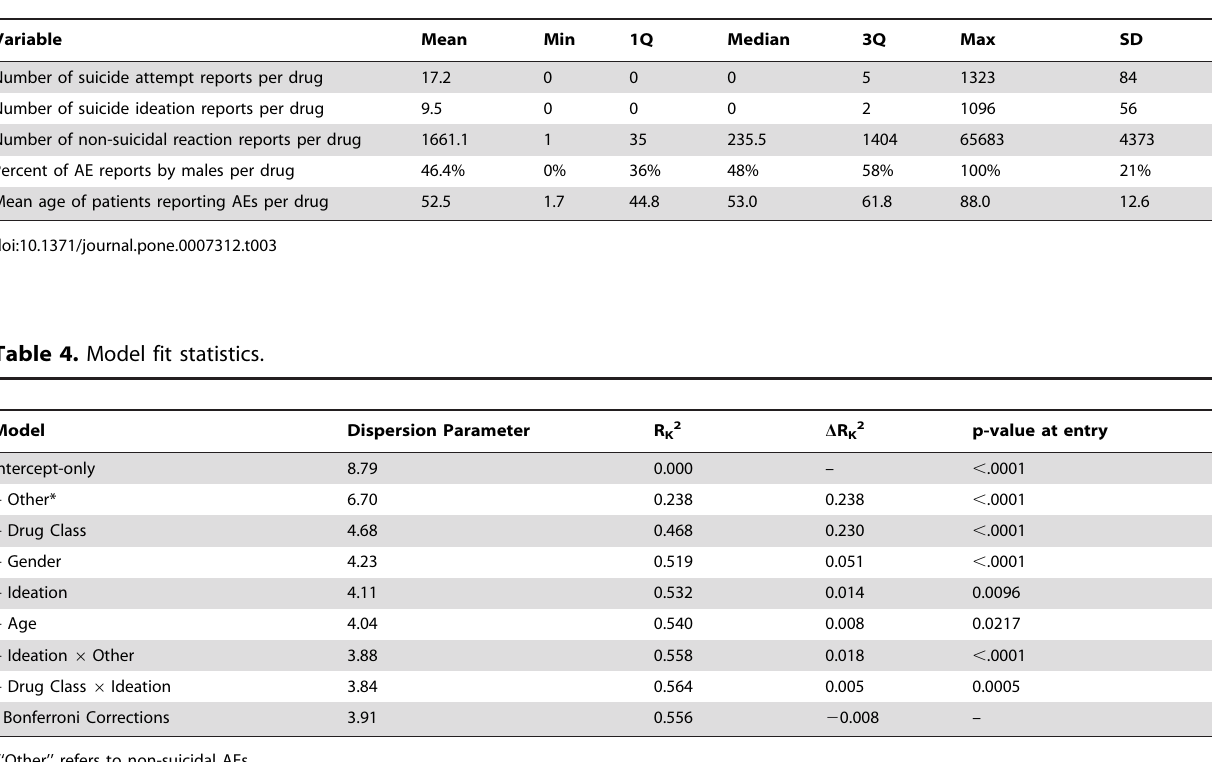
Table 3. Descriptive statistics by drug.